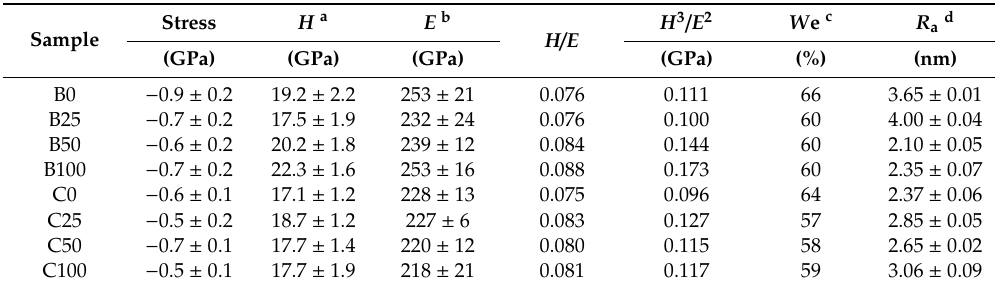
Table 5. Mechanical properties of W–Si–N films.